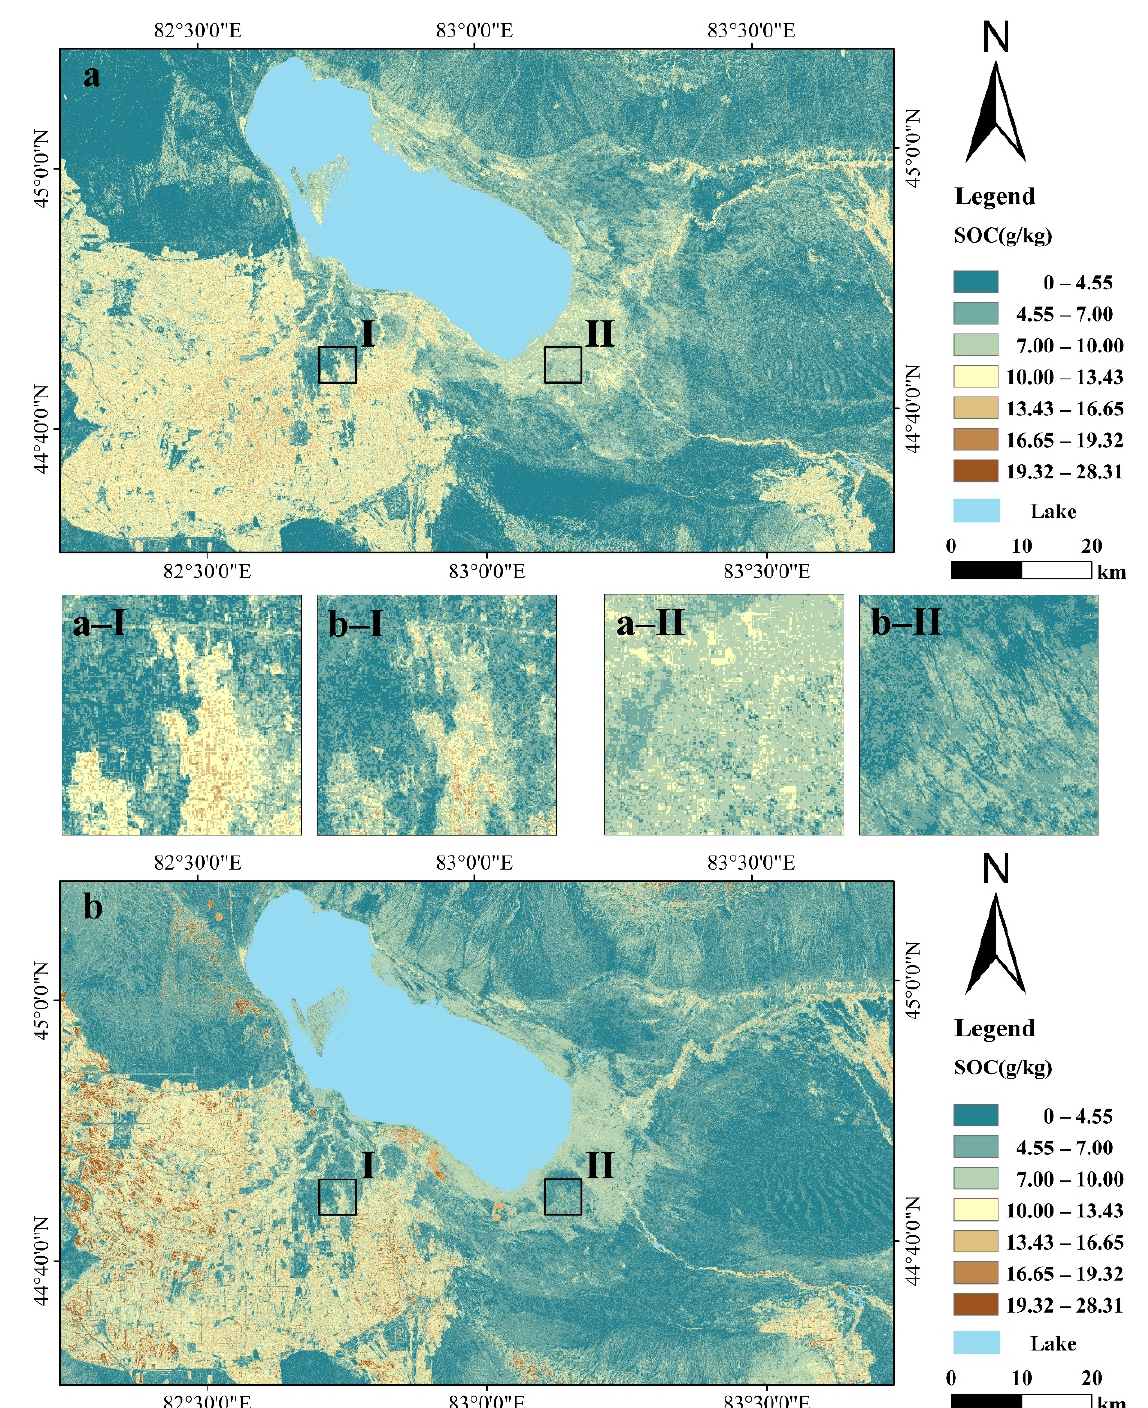
Figure 3. ( a ) Spatial distribution of SOC content predicted using the Landsat 8 model; ( b ) spatial distribution of SOC content predicted using the full variable Sentinel-2A model; ( a - I ), ( a - II ), ( b - I ) and ( b-II ) show specific details in an area for comparison.